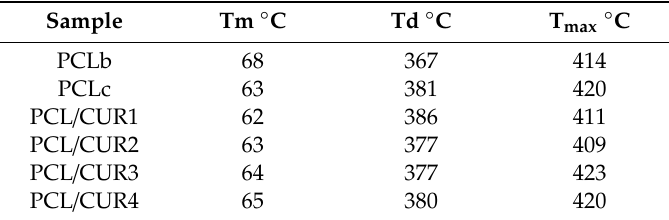
Table 5. The thermal behavior of PCL / CUR